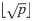
Error rate estimates for the binary null case study (unbalanced).Shown are different error rate estimates for the setting with two response classes of unequal size (smaller class containing 30% of the observations) and without any predictors with effect. The error rate was estimated through the test error, the OOB error, the stratified OOB error, the CV error, and the stratified CV error for settings with different sample sizes, n, and numbers of predictors, p. The mean error rate over 500 repetitions was obtained for a range of mtry values. The vertical grey dashed line in each plot indicates the most commonly used default choice for mtry in classification tasks, that is ⌊p⌋.